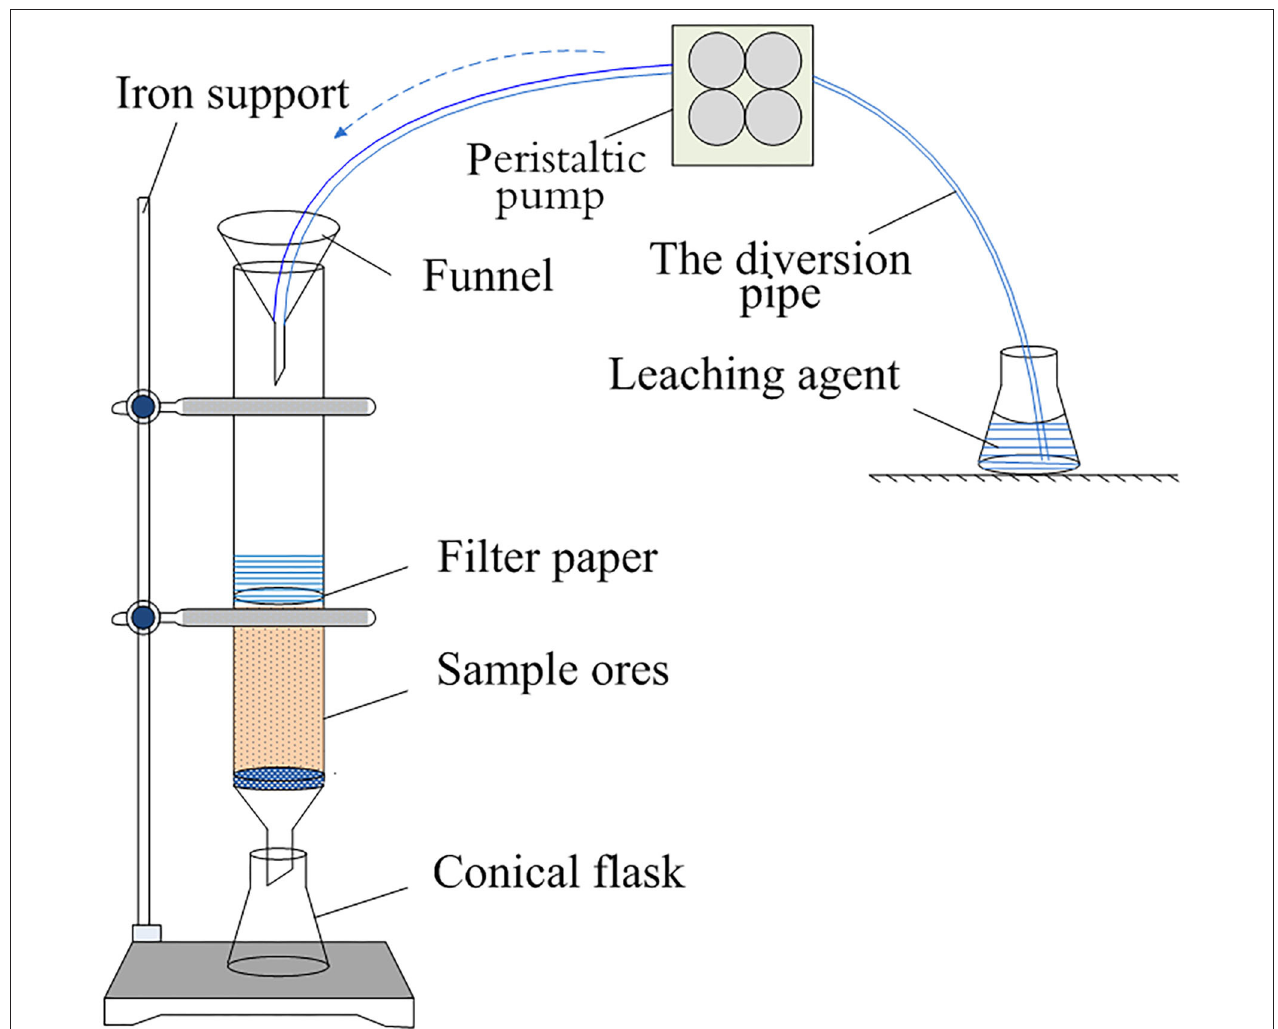
FIGURE 2 | Self-made leaching